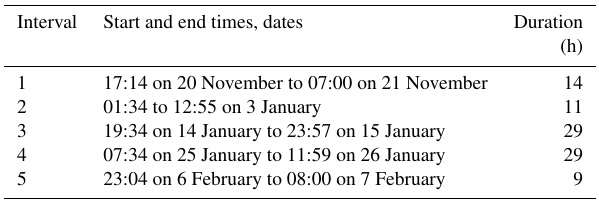
Table 1. Analyzed pre-consolidation frazil intervals. Times are given in Mountain Standard Time